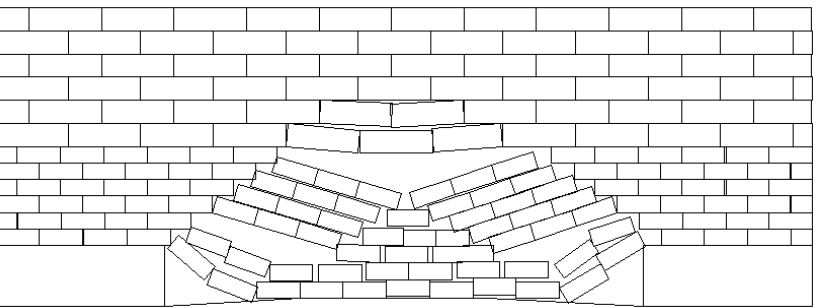
Figure 2. Separation model of overlying strata in goaf.